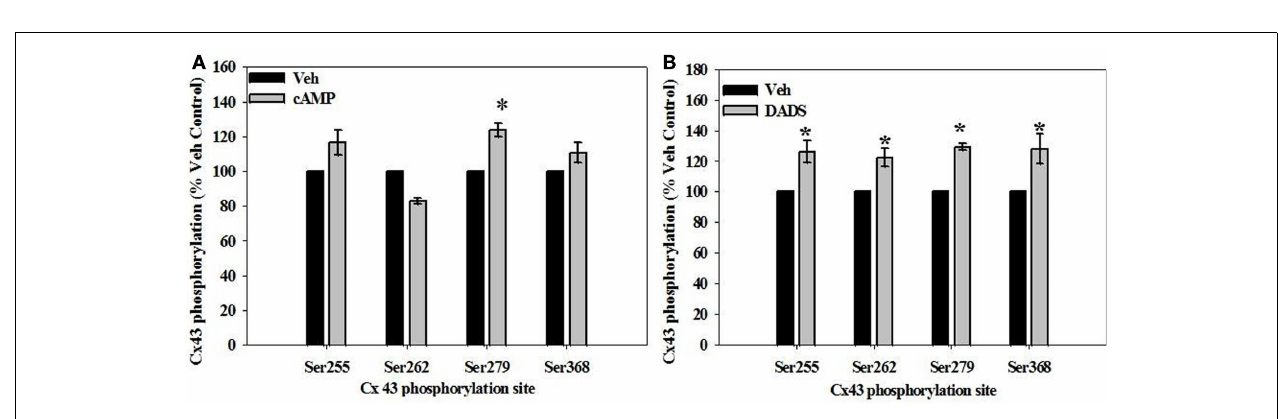
FIGURE 7 | Effect of kinase inhibition on (A) 8Br-cAMP- and (B) DADS-stimulated GJIC estimated by FRAP. Rat primaryVSMCs were incubated for 15min in the presence of the following PKA, PKG, and PKC inhibitors: PKI (10 µ M), DT-2 (10 µ M), and Calphostin-C (100nM), respectively, followed by 8Br-cAMP (100 µ M) or DADS (50 µ M) alone for 15min. (A) Stimulation of GJIC by 8Br-cAMP was effectively inhibited by PKC inhibition alone but not by inhibition of PKA or PKG.